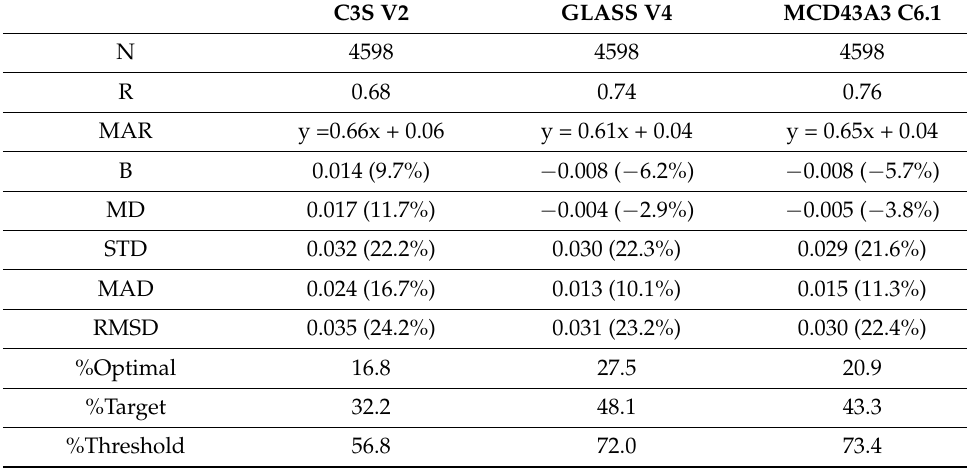
Table 13. Summary of the main statistics for the direct validation of C3S V2, GLASS V4, and MCD43A3 C6.1 satellite blue-sky albedo products vs. blue-sky albedo ground values from the REALS dataset in the 2000–2019 period. Only best quality pixels were taken into